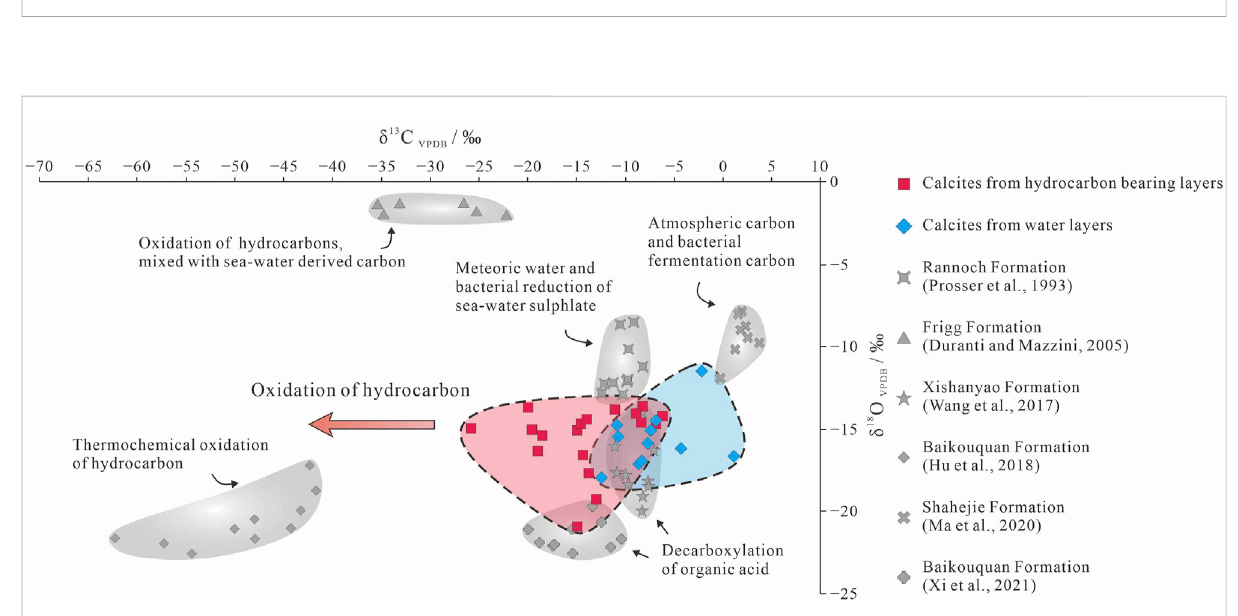
FIGURE 8 Carbon and oxygen isotopic compositions of the P 3 w calcite compared with typical authigenic calcite in siliciclastic rocks.